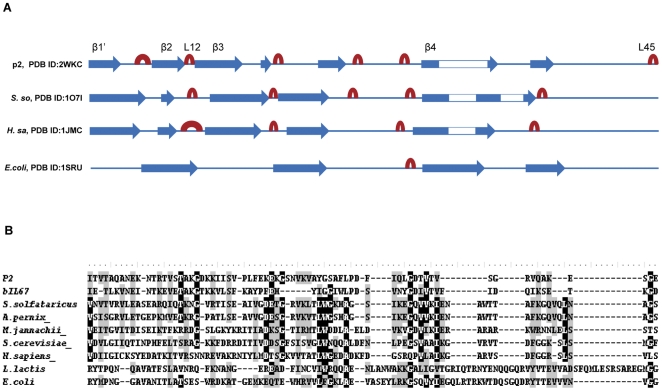
Alignment of ssDNA-binding OB-fold domains of Orf14bIL67–like, prokaryotic, archaeal and eukaryotic proteins.
A: Important elements of the secondary structure of phage p2, S. solfataricus, H.sapiens and E. coli ssDNA-binding proteins. strands are colored in blue, loops are colored in red. Structural data are available in Protein Data Bank (PDB identifiers for p2, S. solfataricus, H.sapiens and E. coli ssDNA-binding proteins are 2WKC, 1O7I, 1JMC and 1SRU respectively). B: Bacteriophage sequences (accession numbers: AAR14301 for phage p2 SSB and AAA74351 for phage bIL67 SSB) aligned with the ssDNA-binding OB-fold domains of S. solfataricus SSB (accession number: AAK42515.1), A. pernix SSB (accession number: BAA80315), M. jannachii RPA (accession number: MJ1159), E. coli SSB (accession number: AAC43153), L. lactis SSB (accession number: AAK06288), S. cerevisiae RPA70 (accession number: CAA42420.1), H. sapiens RPA70 (accession number: AAS94324.1). Conserved residues are shaded grey and identical residues are shaded black.